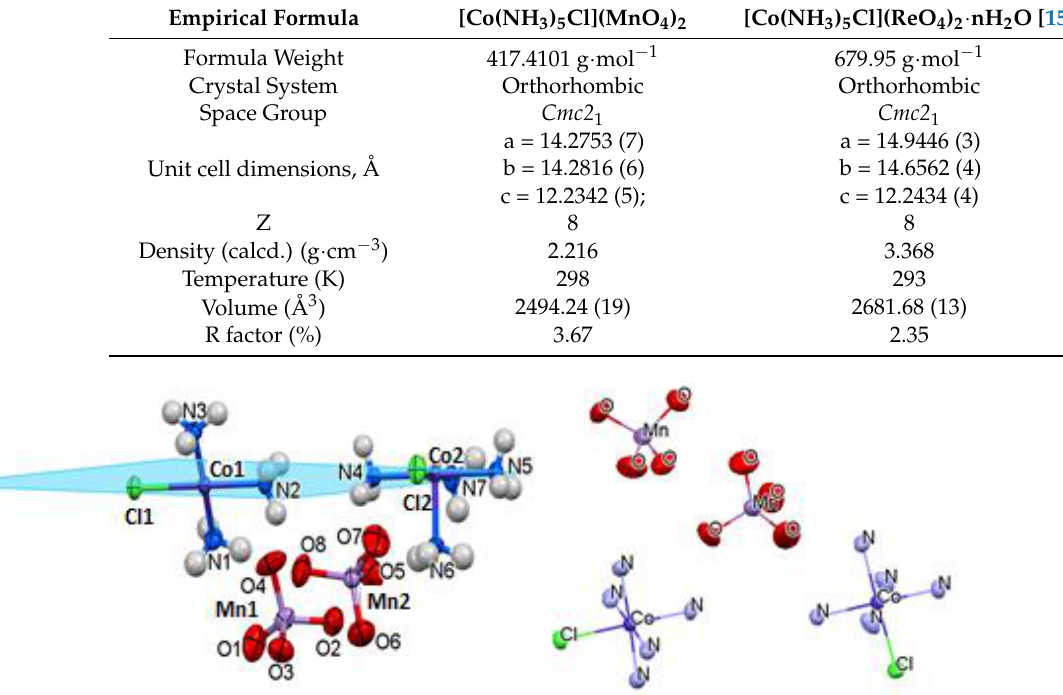
Figure 1. Content of the asymmetric unit of [Co(NH 3 ) 5 Cl](MnO 4 ) 2 containing two half complex cations and two anions (the light blue plane is a mirror plane cutting the complex cations into two halves; thermal ellipsoids are drawn at a 50% probability level).